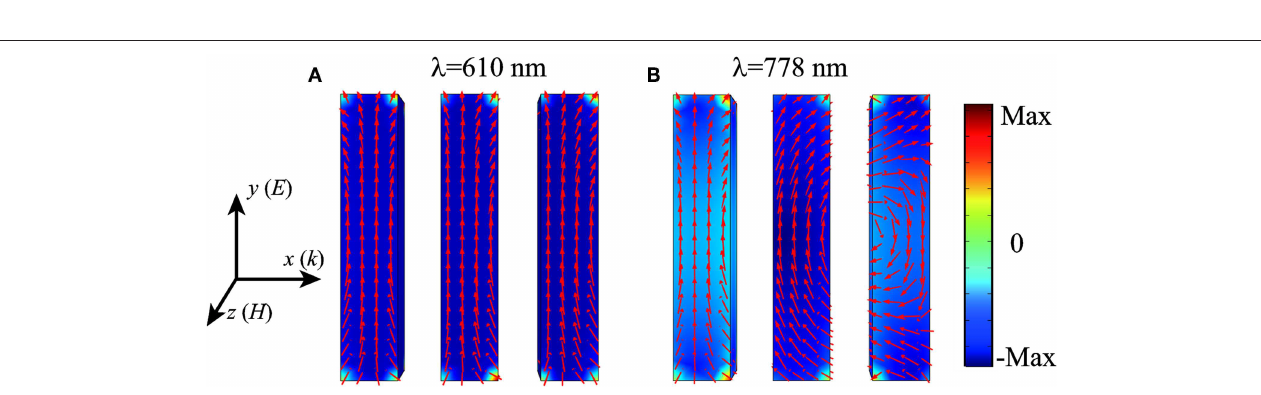
FIGURE 3 | Surface charge distributions for the two resonant peaks [610nm (A) and 778nm (B) ] when κ = 0 in Figure 2A .